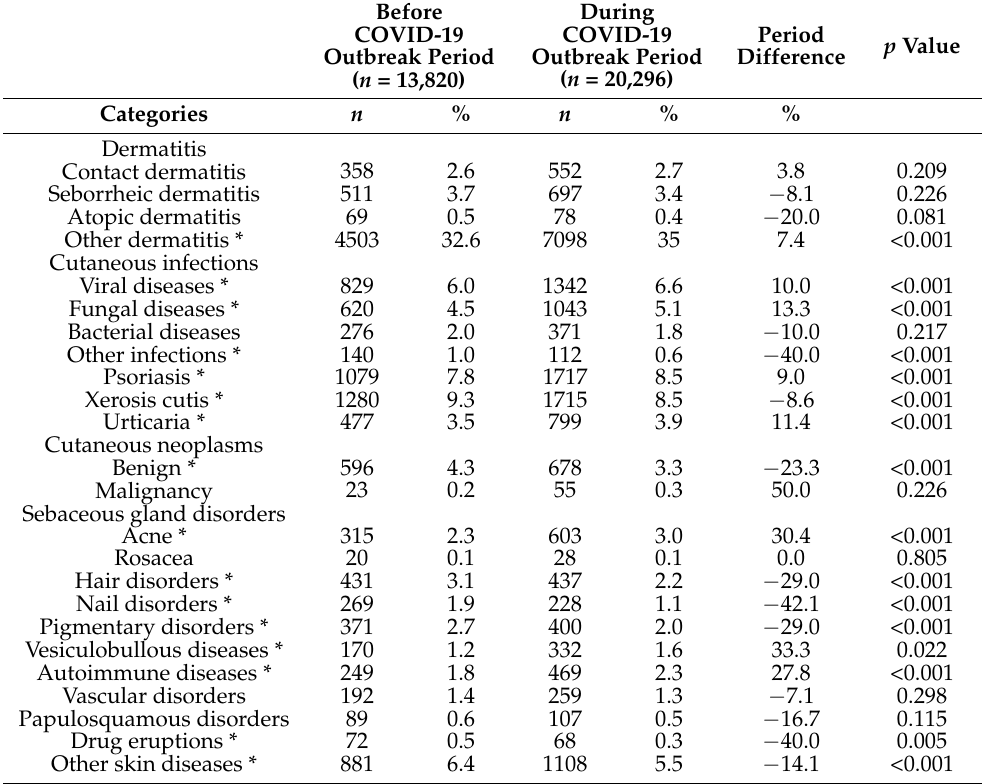
Table 2. A comparison of distribution of diagnosed skin diseases among patients visiting outpatient dermatology clinic at Vajira Hospital, Navamindradhiraj University, between the periods with and without COVID-19